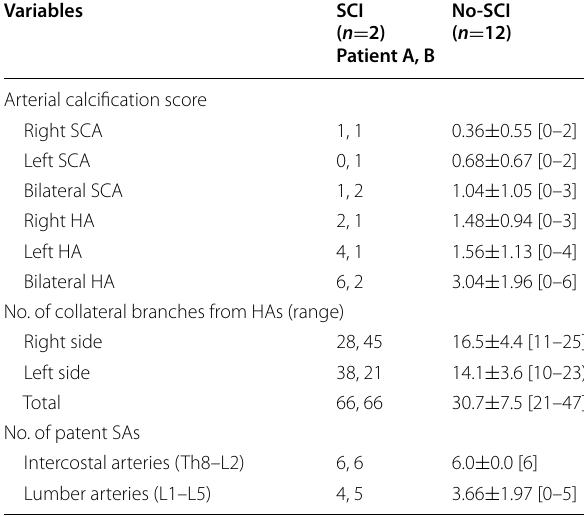
Table 4 Arterial calcification score and the number of collateral